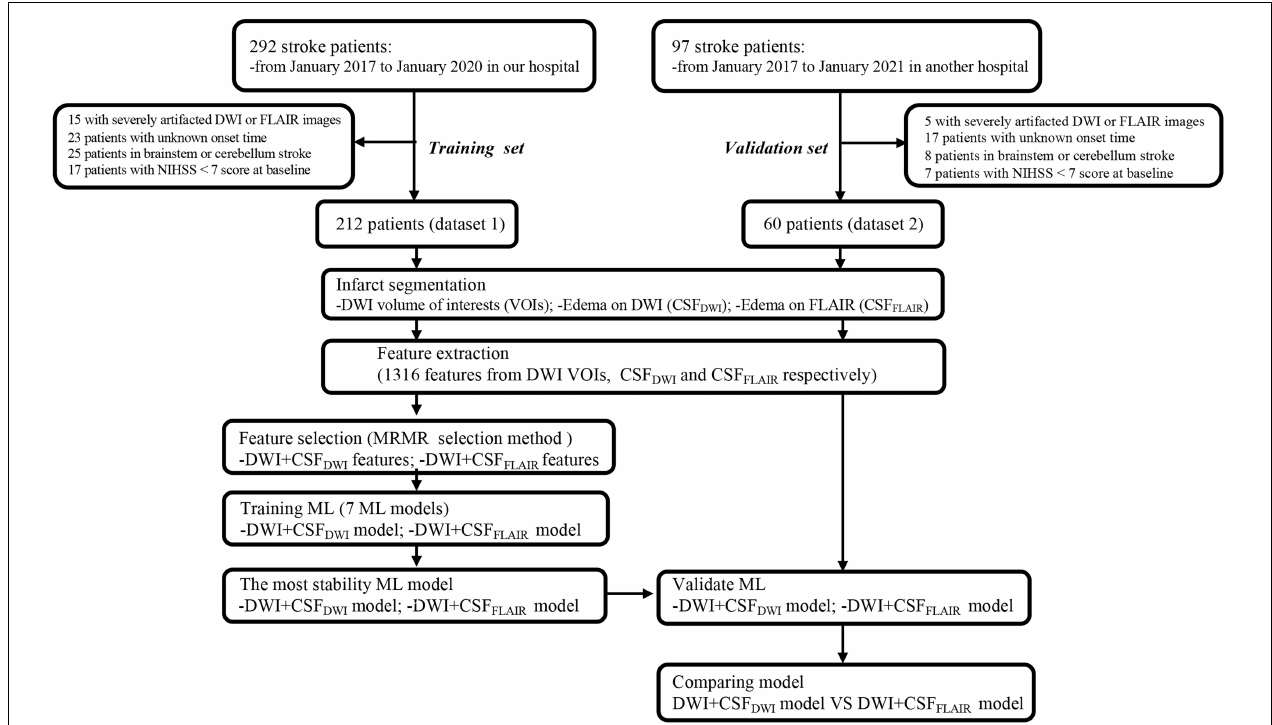
FIGURE 1 | The flowchart of this